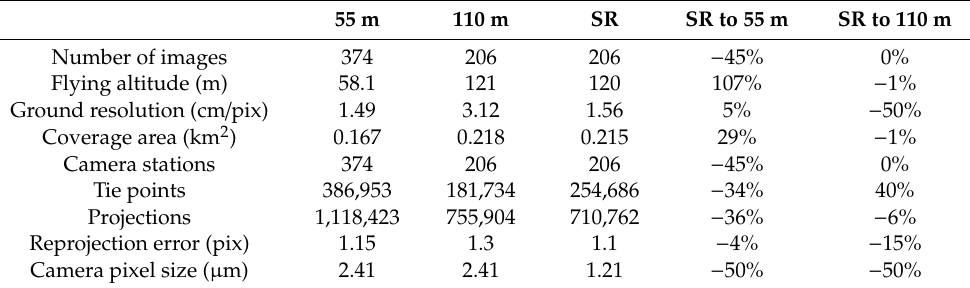
Table 8. Image alignment results for the Phantom 4 Pro.